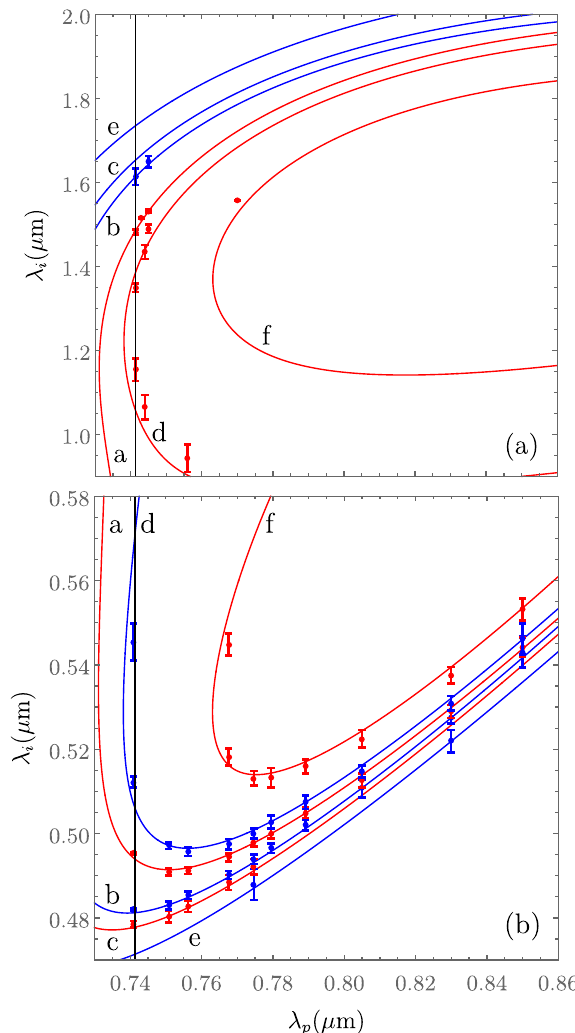
Figure 3. Phase-matching diagrams for the six SFWM processes with signal ( a ) and idler ( b ) arms displayed separately. Red and blue colors corresponds to x - and y -polarized signals, respectively. Points indicate the central wavelength of the measured spectra, while error bars represent their emission bandwidth. Solid lines correspond to the calculated phase-matching diagrams of each process. The vertical black line represents the pump at 0.741 µ m and corresponds to the spectra shown in Fig.